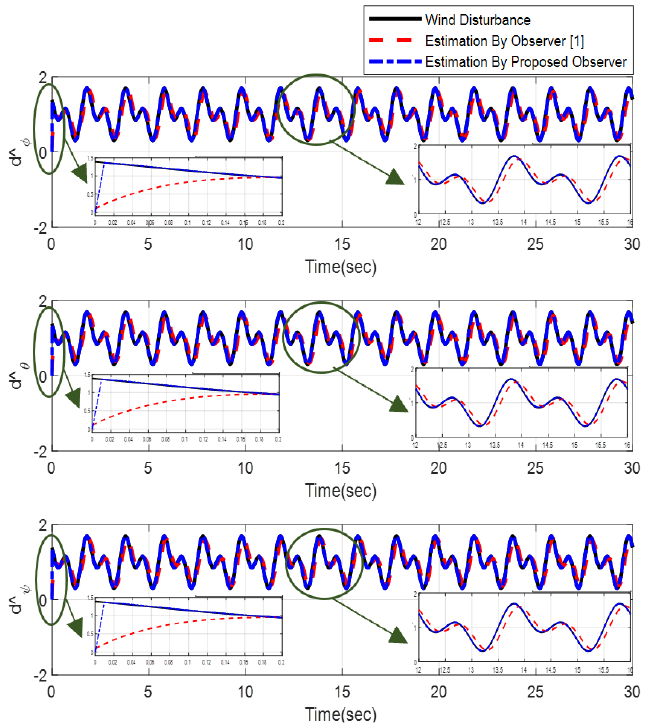
Figure 11. Estimation of wind perturbation entered to the attitude of quadrotor.